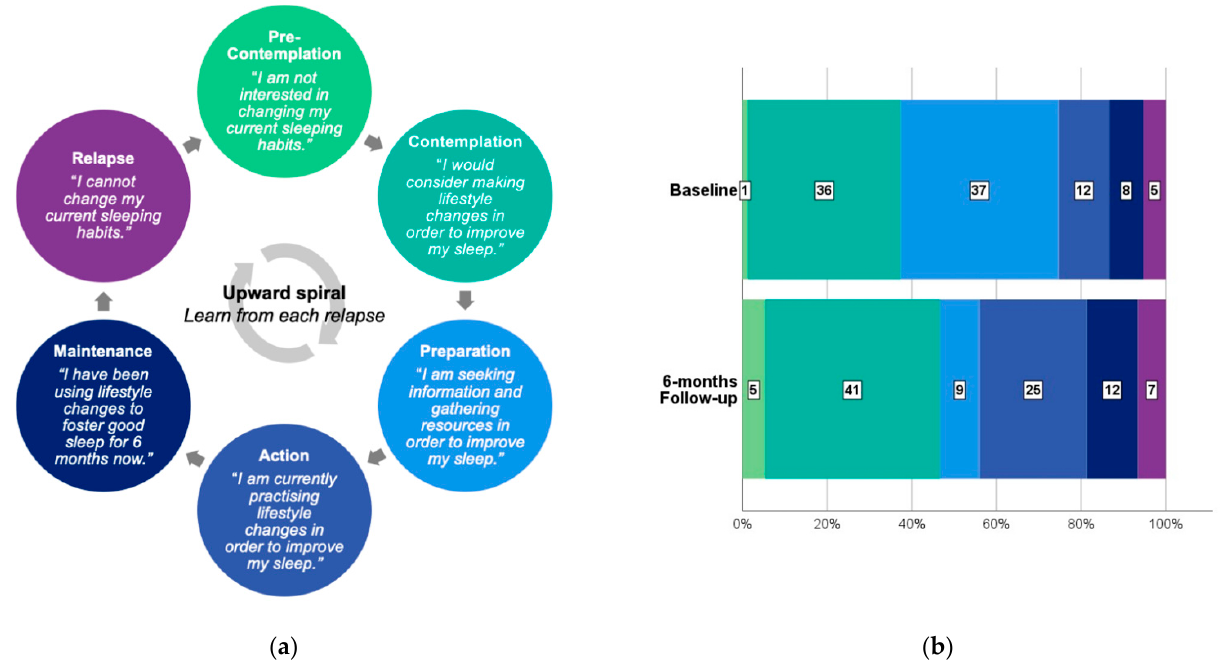
Figure 1. ( a ) Stages of Change Model of behavioural change [25]. ( b ) Students’ ( n = 75) attitudes towards sleep behaviours before and 6 months after completion of a sleep and circadian education course.